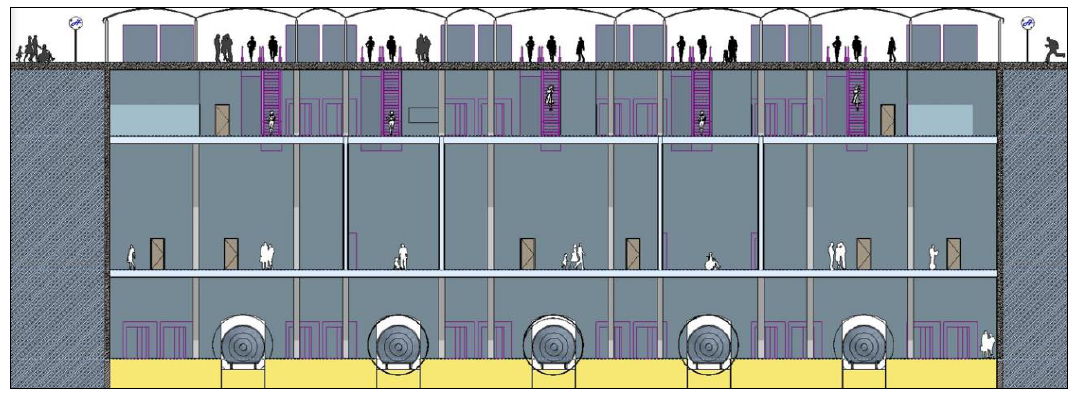
Figure 5. The cross-section of a hyperloop station building.